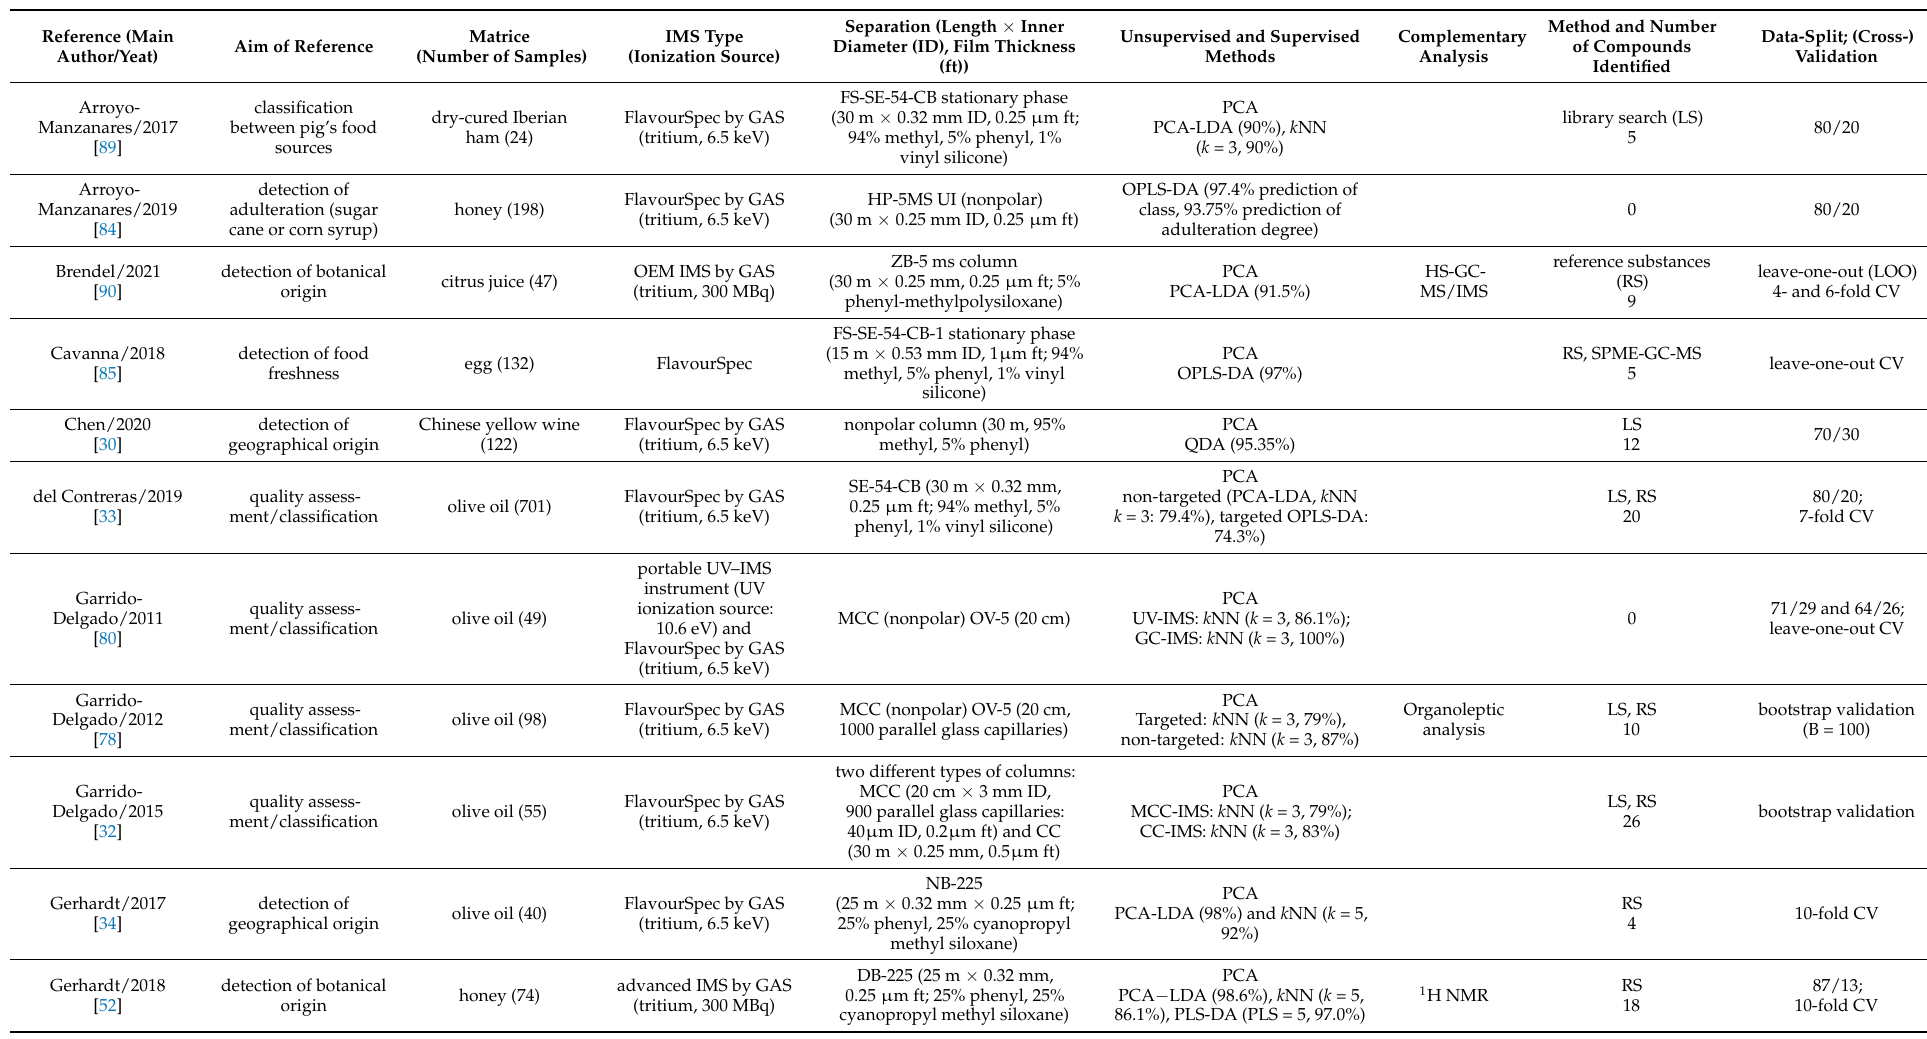
Table 1. Recent studies of HS-GC-IMS with